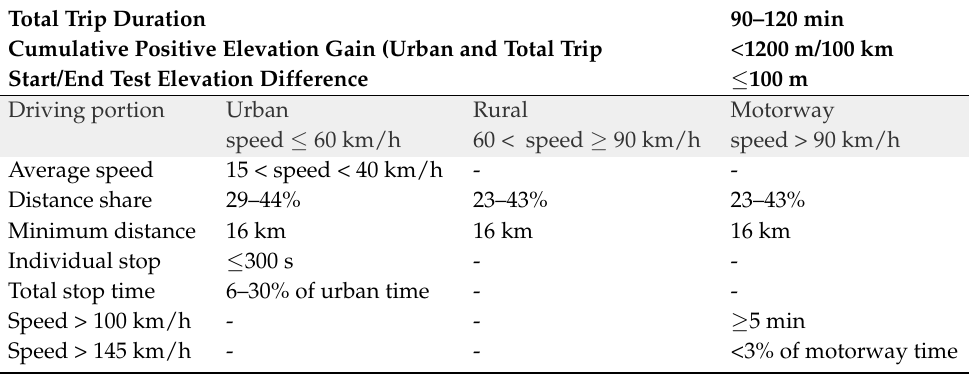
Table 1. Trip requirements for a valid RDE